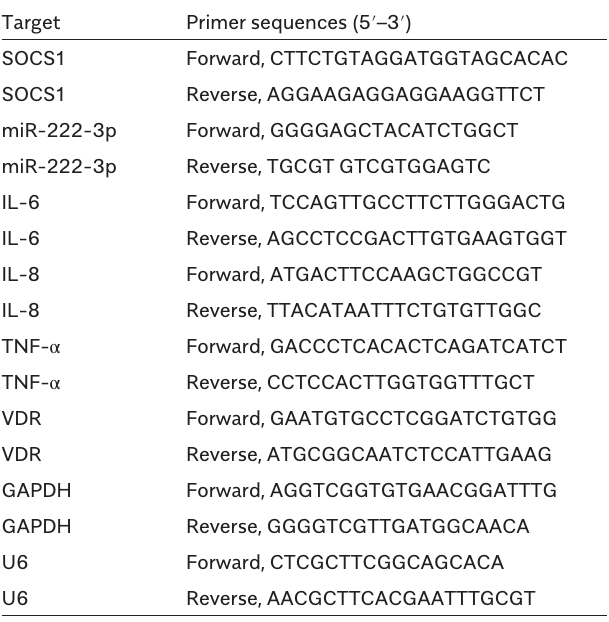
Table 1. Primer sequences used for RT-qPCR